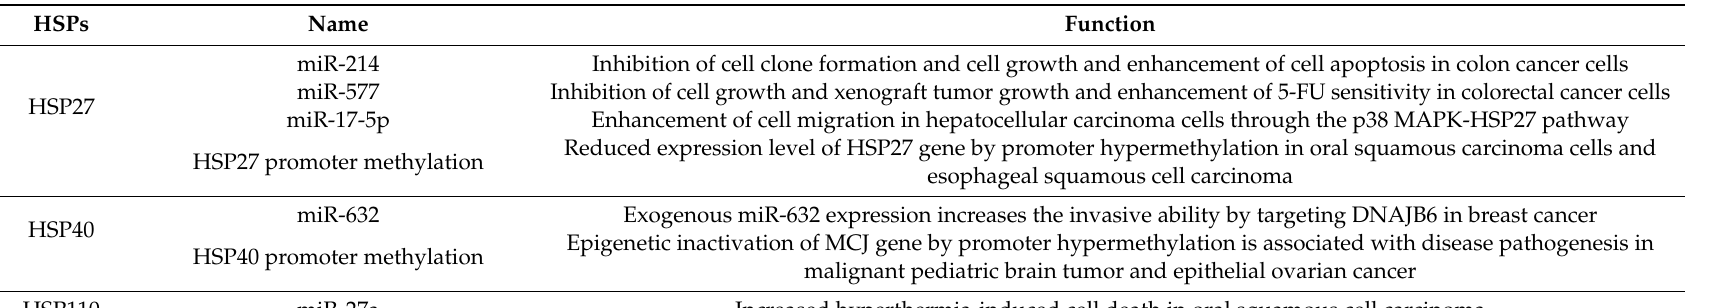
Table 4. Epigenetic regulations for HSP27, HSP40, and HSP110